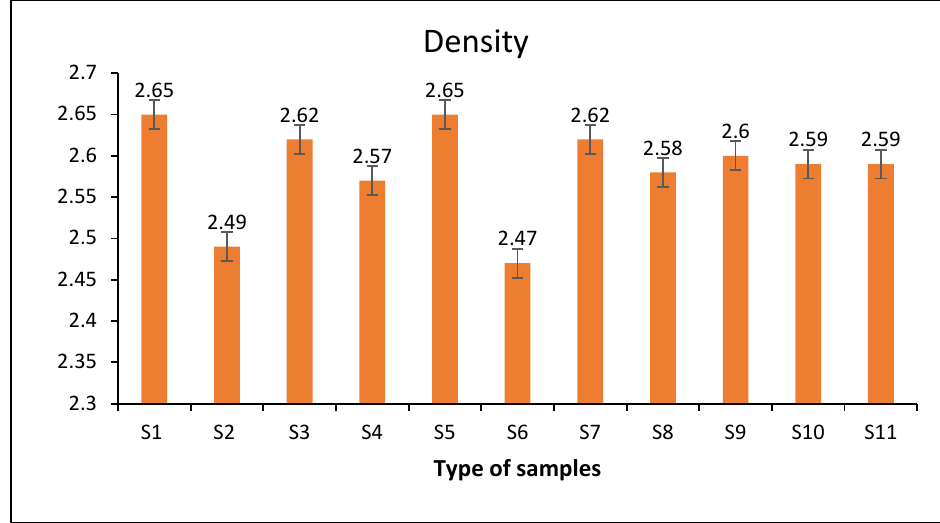
Figure 6. The density of recycled hybrid materials B 4 C and ZrO 2 reinforced.